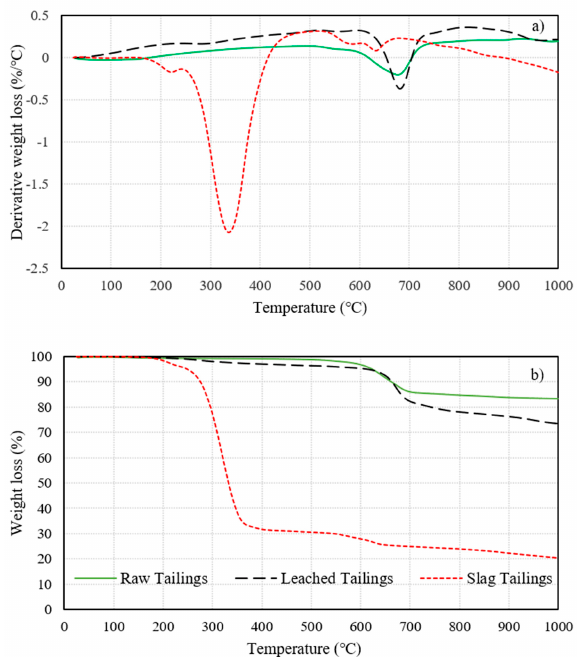
Figure 3. Differential thermogravimetric ( a ) and thermogravimetric ( b ) graphs of raw, acid leached, and slag tailings.